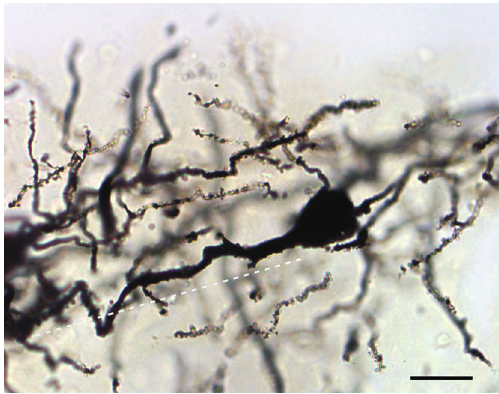
Figure 2: Photomicrograph demonstrating Golgi-Cox impregnated pyramidal neurons of the somatosensory cortex from control adult WAG/Rij rats. Apical dendritic segment is indicated by dashed white line. Scale bar, 20 μ m.